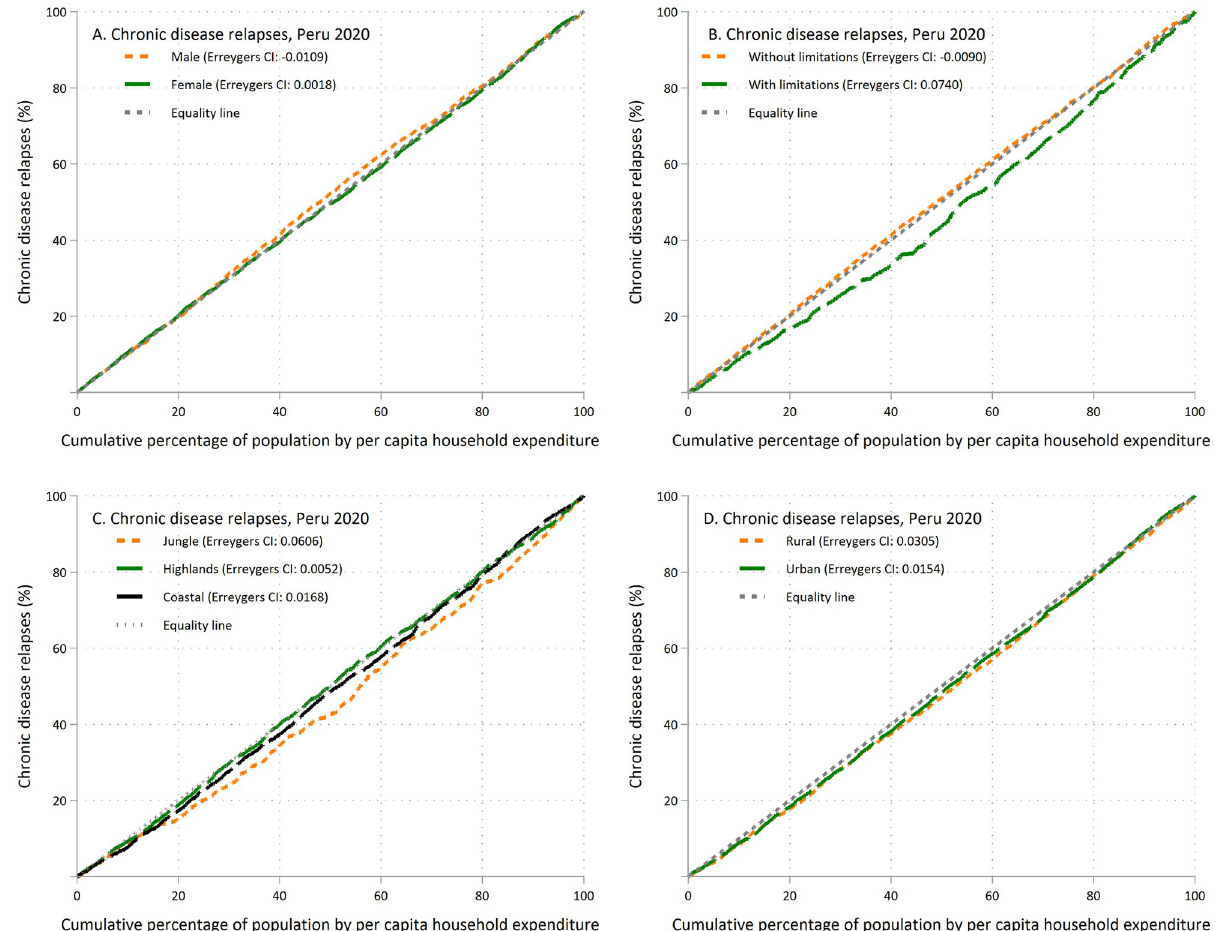
Fig 2. Concentration curves of chronic diseases